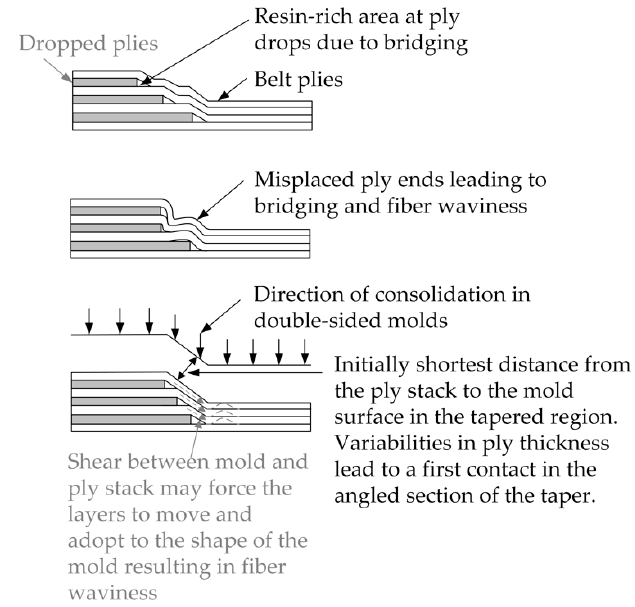
Figure 19. Possible manufacturing effects leading to fiber waviness in ply runout (tapered) regions, modified from [1].